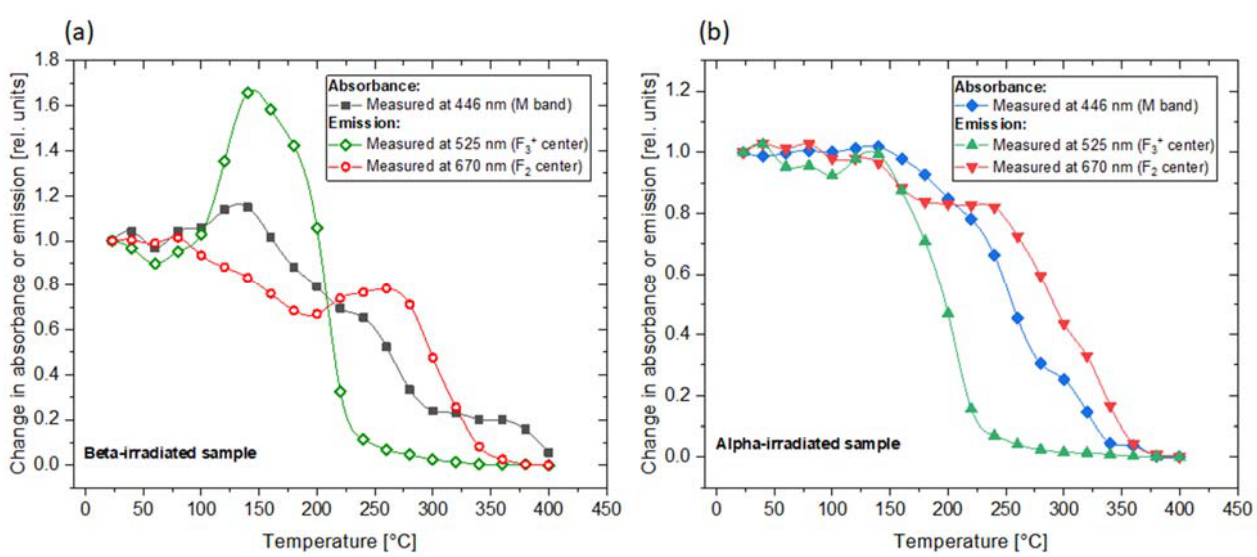
Figure 8. Comparison of the changes in absorption and PL intensity with respect to the values at room temperature measured for: ( a ) sample irradiated with beta radiation (30 kGy) and ( b ) sample irradiated with alpha particles (fluence 3.4 × 10 12 cm − 2 ) and subjected to Method 1.